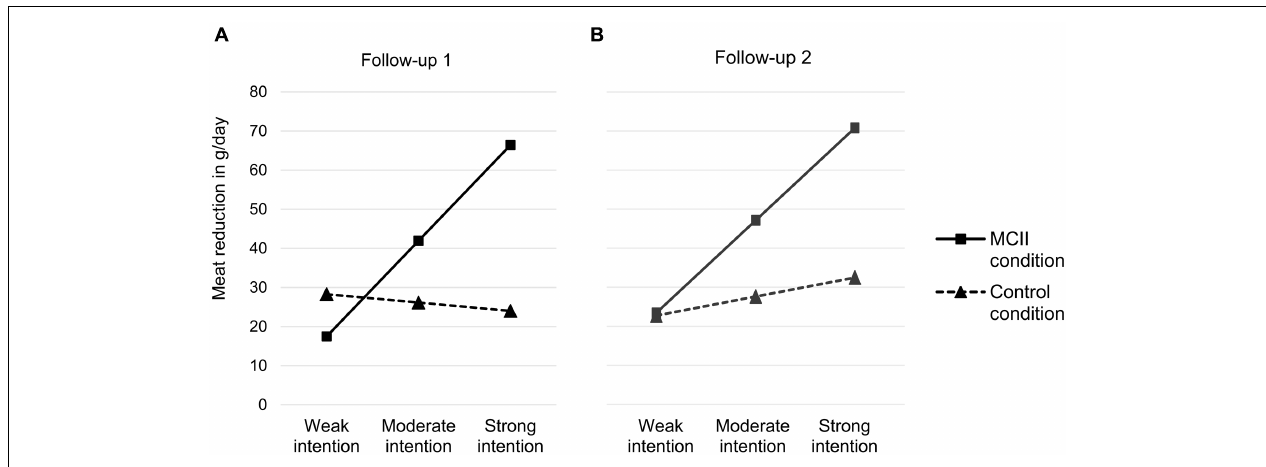
FIGURE 1 | Simple slopes for intention to reduce meat consumption differentiated for intervention condition (control vs. MCII) in the 1st week (A) and 4th week (B) after the intervention. Meat reduction values of this display were calculated for weak intention ( M − 1 SD ), moderate intention ( M ) and strong intention ( M + 1 SD ). MCII, mental contrasting with implementation